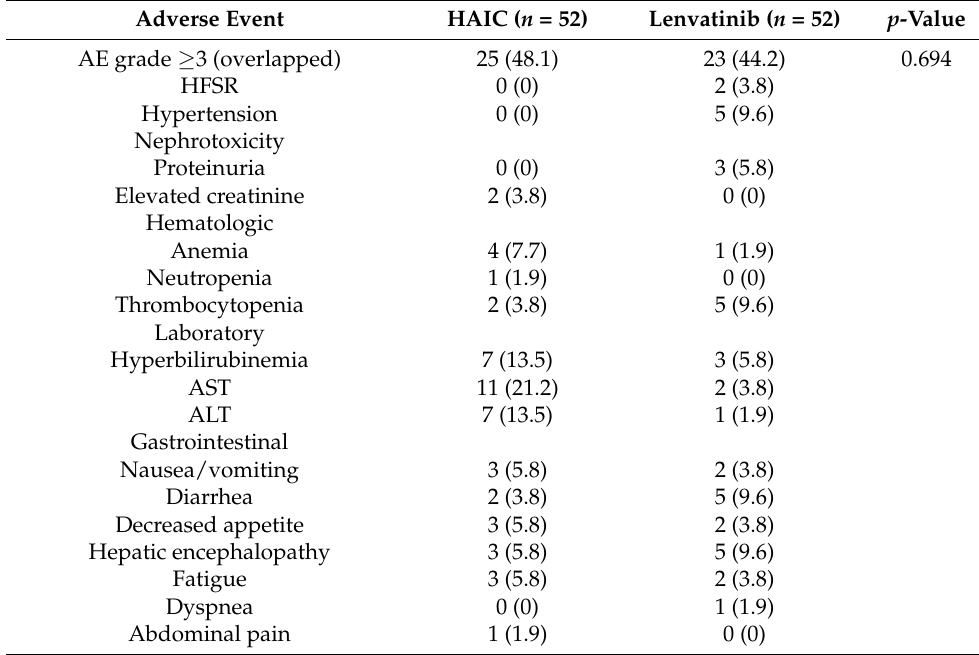
Table 4. Grade ≥ 3 AEs associated with lenvatinib or HAIC treatment after PSM.